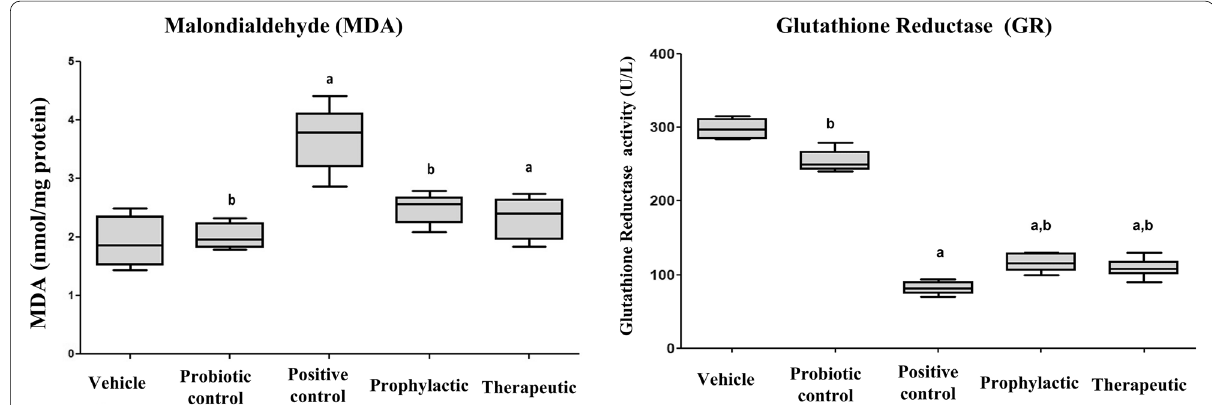
Fig. 2 Effects of probiotic LGG administration on oxidant and antioxidant activity. Levels of malondialdehyde (MDA) and glutathione reductase (GR) were estimated in liver tissue homogenates of the different studied groups. Data presented as mean